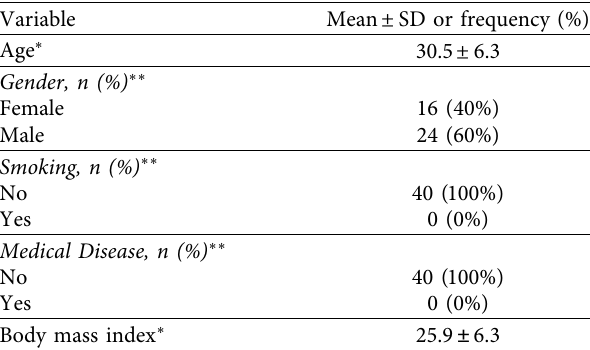
Figure 1: (a) Standard position of anterior precordial leads. The patient’s right side is on the left of the picture. (b) Location of precordial leads on posterior chest in prone position. The patient’s right side is on the right of the picture. The precordial leads are positioned on the posterior chest opposite to their normal anterior location. The limb leads have preserved their left-right orientation. On the right of the spine is lead V1. Leads V2 through V6 are situated to the left of the spine. Table 1: Baseline demographic and clinical characteristics of